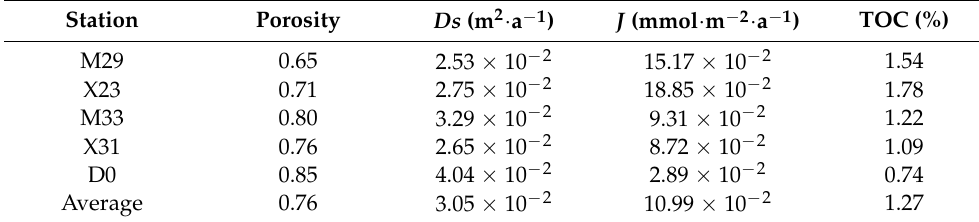
Table 3. Sediment diffusion coefficients Ds , calculated diffusive intensity of methane flux, and the average content of TOC in surface